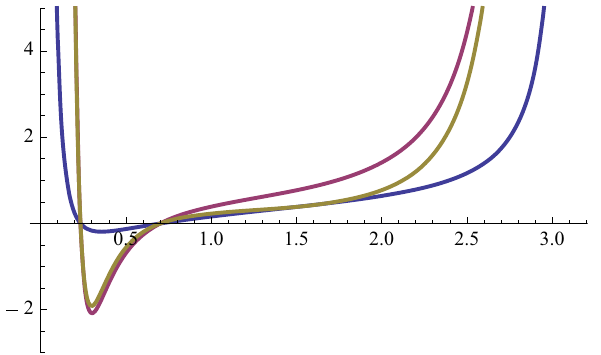
Fig. 4 Plot of effective potential V (χ) for (i) RN black-hole type solu- tion ( K = 0 . 9, Q = 1, R 0 = 1) for S 3 -I. [ L = 0 (blue), L = 1 (red) for timelike and L = 1 for null.] The shape of the potential shows that the two singularities are not accessible except by the radial ( L = 0) null geodesic. The geodesic observers can get into the inner region of the black hole. Then they bounce to the outer region in the other copy of the spacetime as usual in the Reisner–Norström geometry in which there exists an infinite tower of spacetime